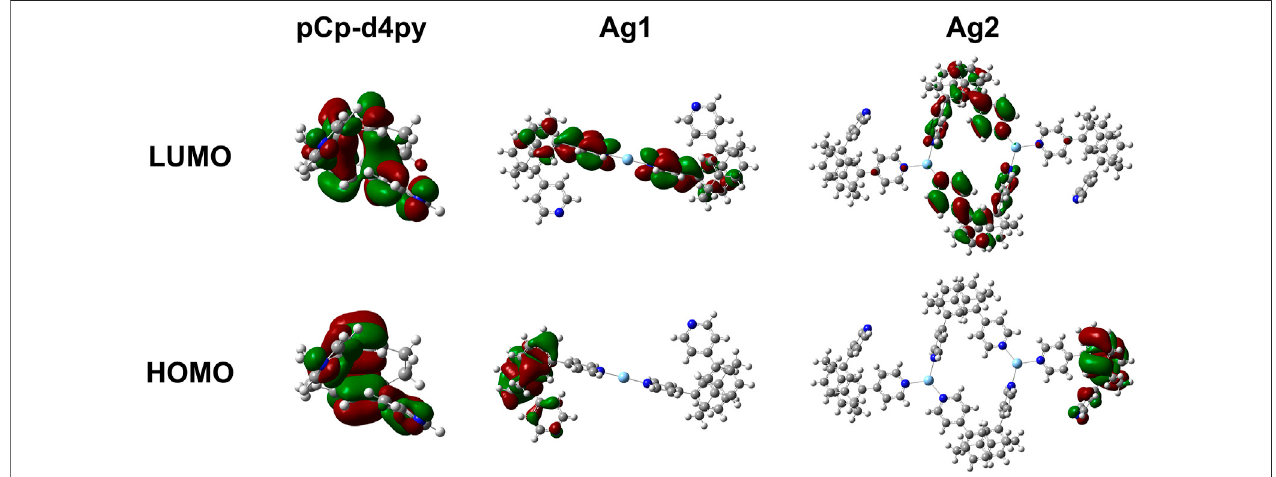
FIGURE 4 | Plots of the molecular orbitals (top – LUMO, bottom – HOMO) for pCpd4py and the two different Ag-containing model units from